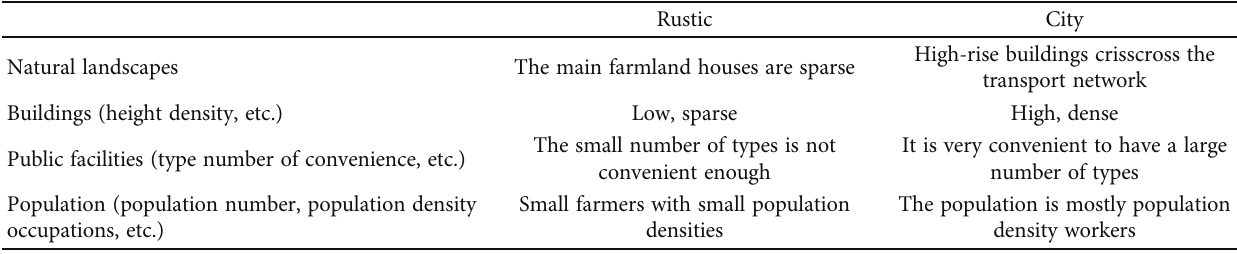
Table 1: Comparison of rural landscape and urban